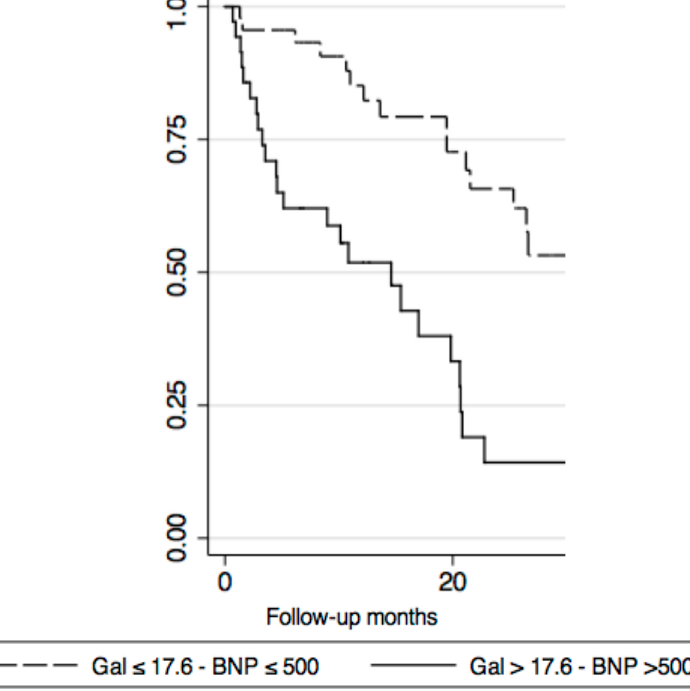
Figure 2. Kaplan–Meier curve with Galectin-3 > 17.6 ng/mL and BNP > 500 pg/mL (log-rank 17.96; p < 0.00001).